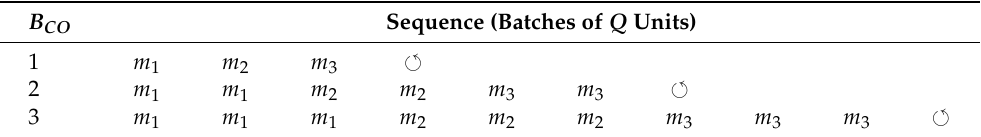
Table 6. Production sequence input data.